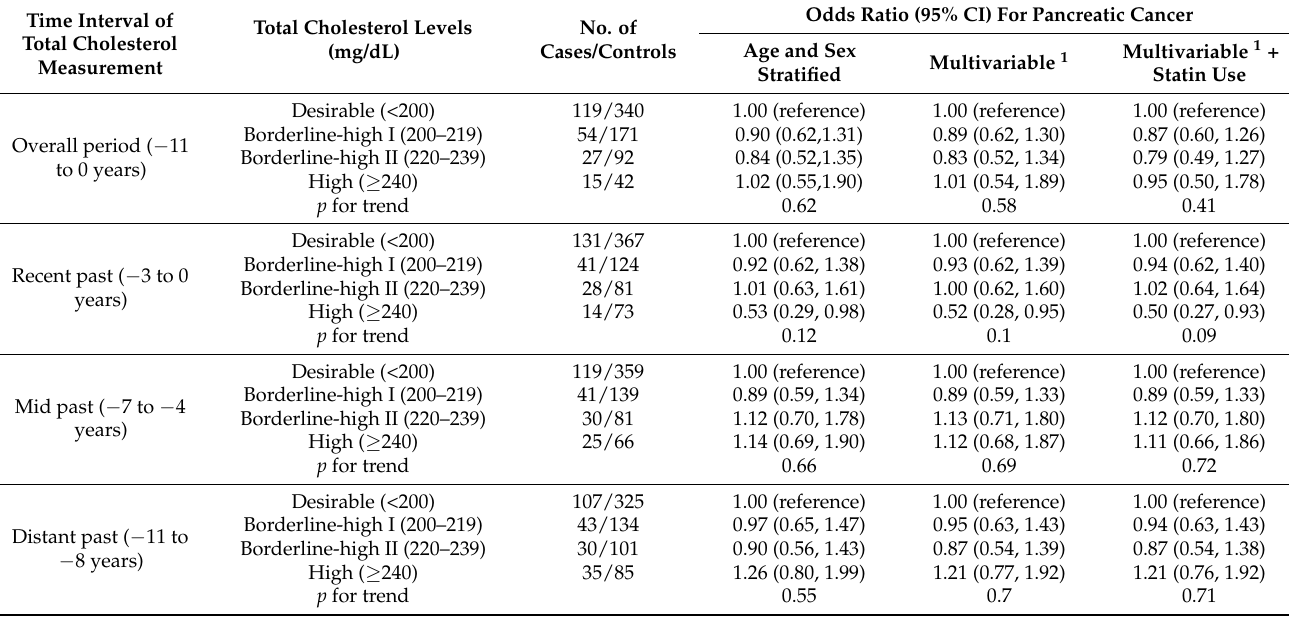
Table 2. Odds ratios and 95% confidence intervals of pancreatic cancer by total cholesterol levels at different time intervals.